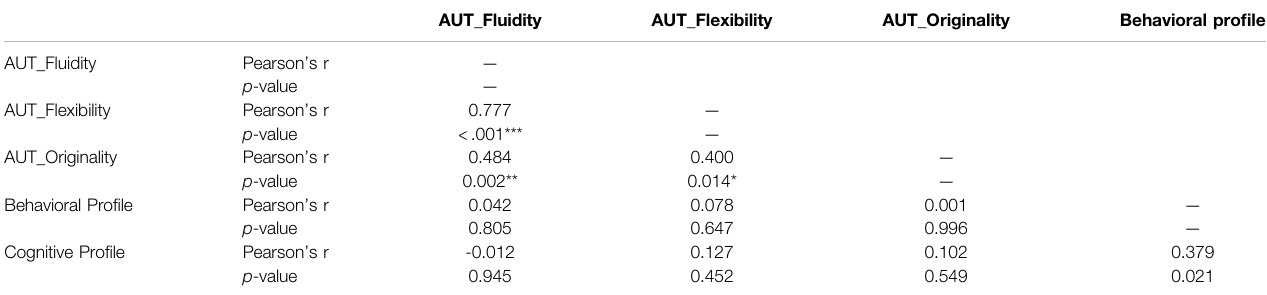
TABLE 1 | Correlation scores between the AUT task component, behavioral pro fi les (CreaCube task-creative or conservative), and cognitive pro fi les (answers to why the CreaCube activity was